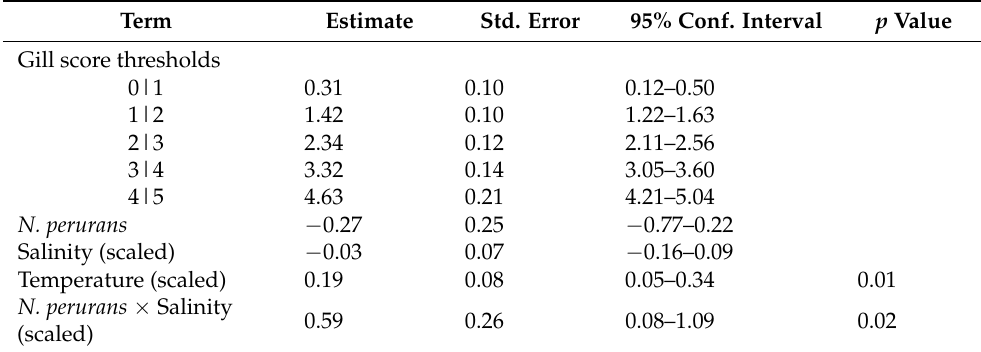
Table 4. Coefficients, standard error, 95% confidence intervals, and p -values for the final ordinal logistic